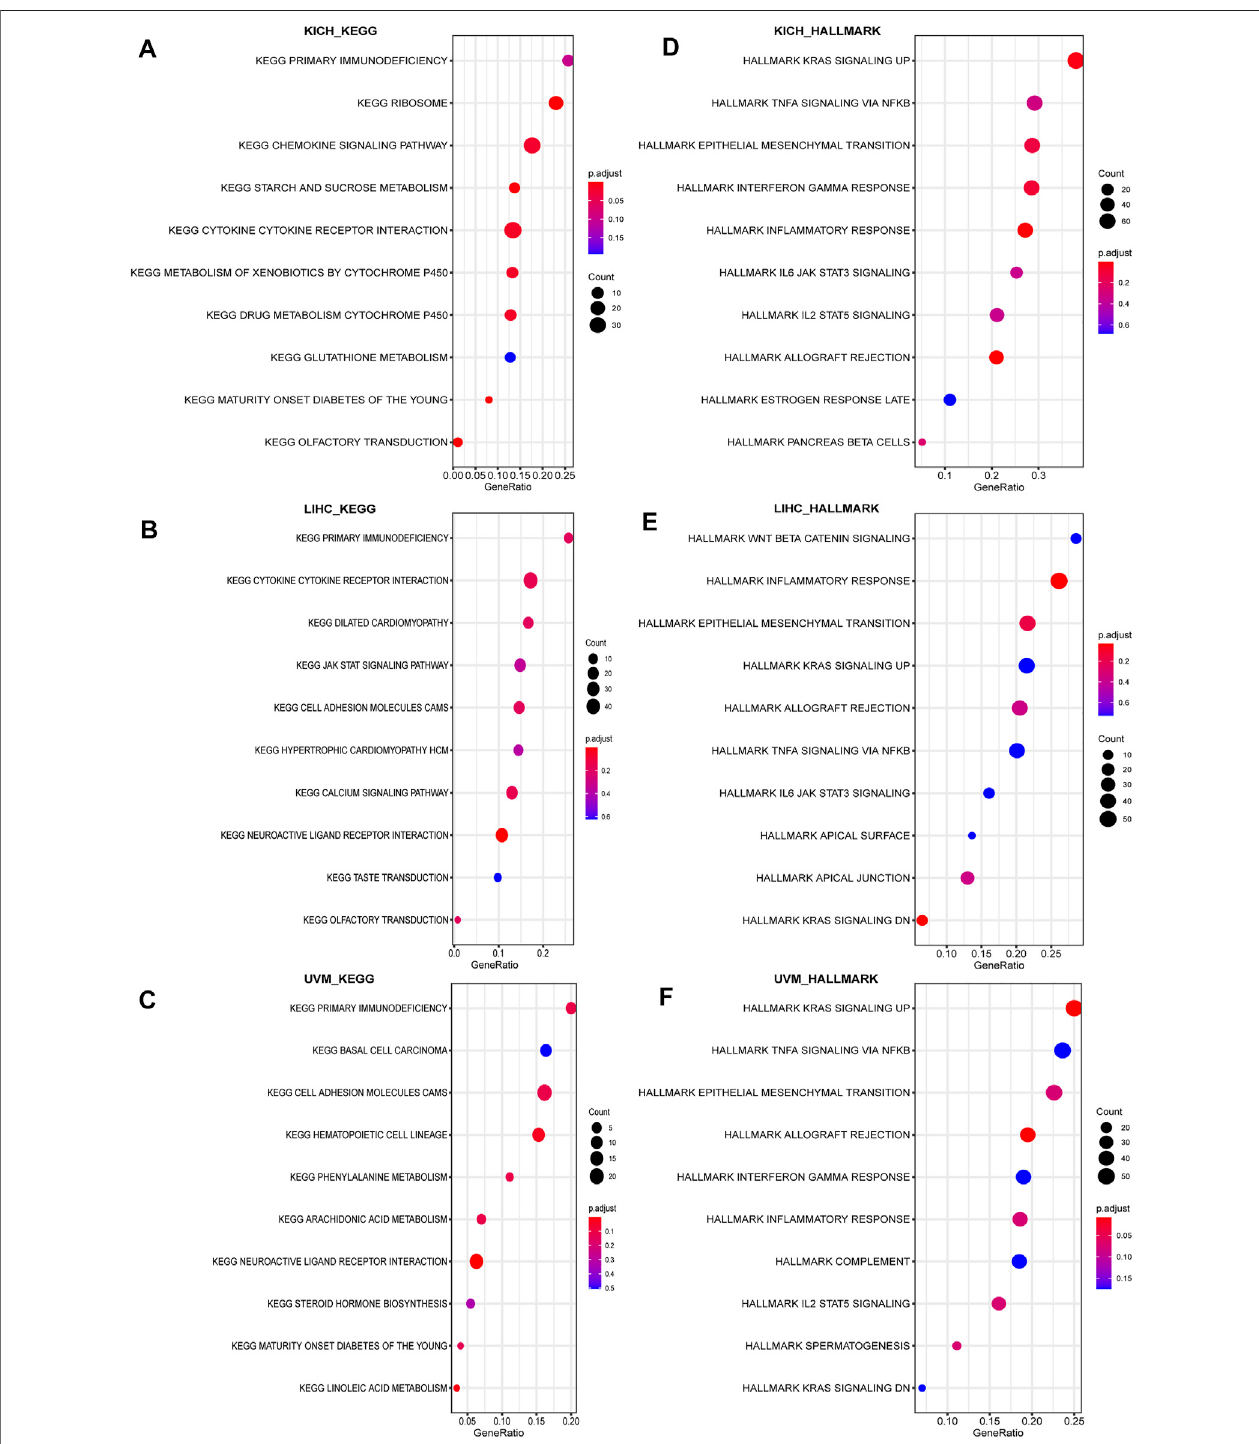
FIGURE 9 | Result of GSEA. Different KEGG and HALLMARK pathways regulated in KICH (A – B) , LIHC (B – D) , and UVM (E – F) .